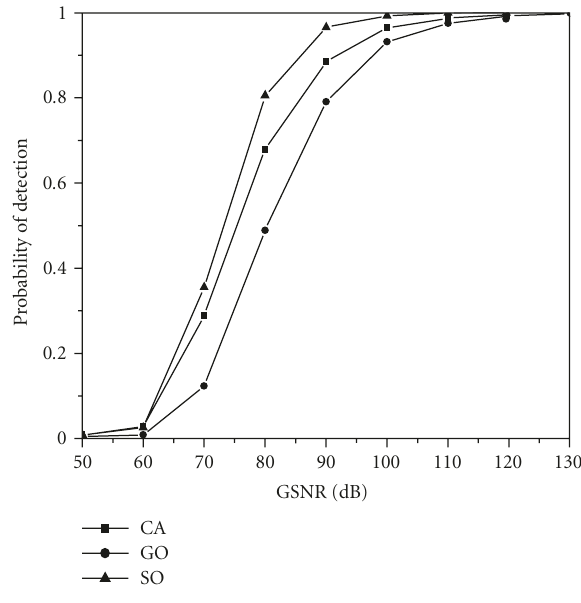
Figure 3: Probability of detection of CA, CAGO, and CASO CFAR processors in homogeneous Pearson background as a function of GSNR = 20log( σ s /γ ). Reference window size is N = 32, P CA P CAGO = P CASO = 10 − 4 . fa fa